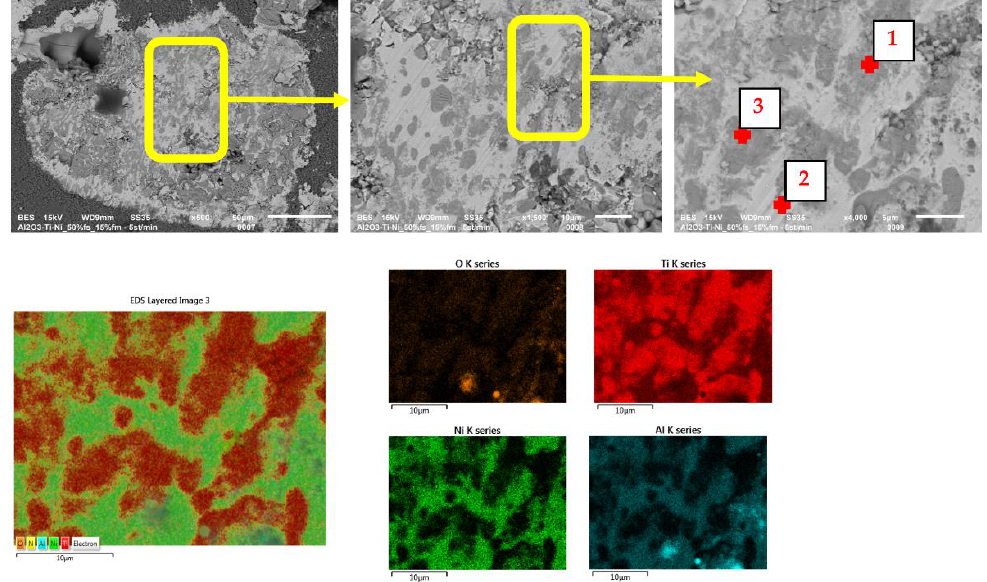
Figure 11. SEM/EDS results of samples with 15% volume of the metallic phase. 445 Table 4. Chemical composition of characteristic areas of the composites. Measurement areas are 446 shown in Figures 9 – 11. 447